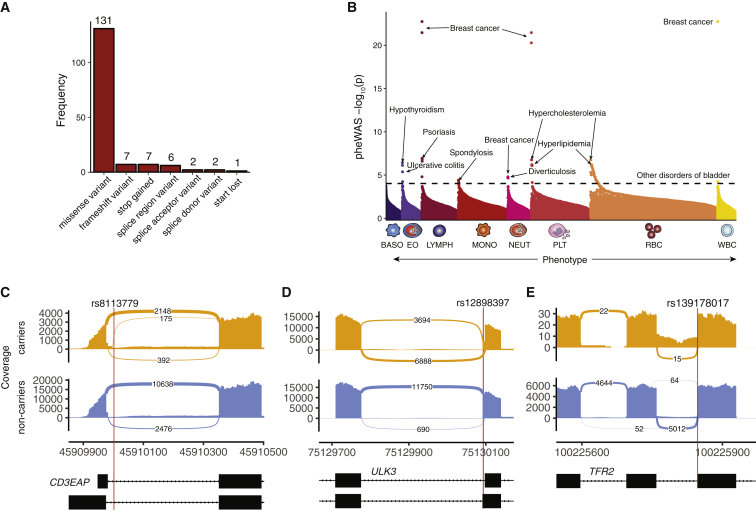
Characterization of Rare Blood Trait Variants(A) Distribution of coding consequences of 456 rare variants (MAC > 20, MAF < 1%), annotated using VEP.(B) Phenome-wide association study of these 456 rare variants across 529 well-represented clinical phenotypes in the UK Biobank (n up to 408,961). Variants are grouped by the hematopoietic lineage with which they are associated (BASO, basophil; EO, eosinophil; LYMPH, lymphocyte; MONO, monocyte; NEUT, neutrophil; PLT, platelet; RBC, red blood cell; WBC, white blood cell). Some variants appear in more than one category if they are associated with traits from distinct lineages. Text labels indicate the clinical outcomes with the strongest association per category. The dotted line denotes the Bonferroni-adjusted significance level (corrected for 529 phenotypes).(C–E) Sashimi plots depicting splice alterations at 3 loci as determined by RNA-sequencing analysis, comparing carriers of a specified blood trait variant (top track) versus non-carriers (bottom track). (C) Intronic donor gain splicing event in CD3EAP among carriers of rs8113779 (PPFM = 0.23 for PLT, 2nd highest in credible set). Numbers within the splice junctions represent the number of reads supporting the junction. The x axis marks genomic coordinates. (D) Exonic donor gain splicing alteration in ULK3 associated with rs12898397 (PPFM = 0.071 for lymphocyte percent, 5th highest in credible set). (E) Donor loss splicing event in the TFR2 locus, induced by variant rs139178017 (PPFM = 0.73 for RDW, highest in credible set; PPFM = 0.4 for MCV, 2nd highest in credible set).